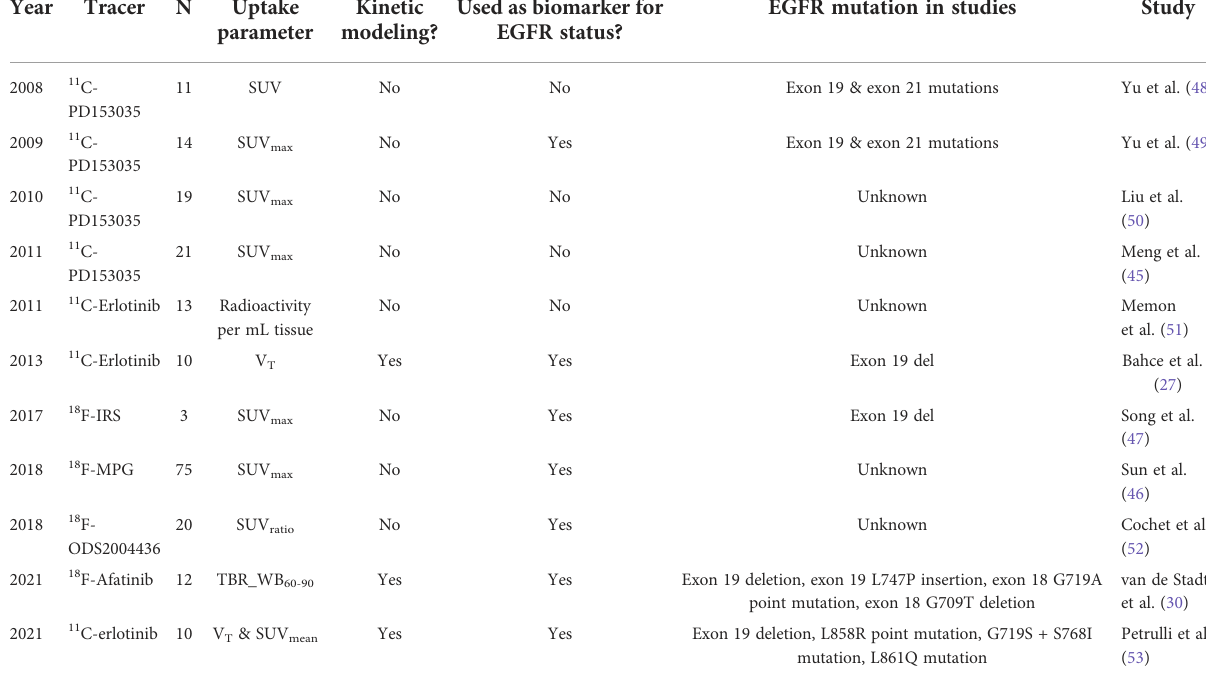
TABLE 1 Overview of clinical EGFR TKI PET studies.